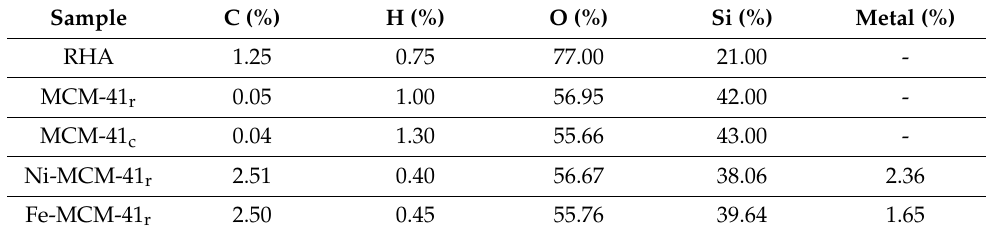
Table 1. Elemental composition of RHA and